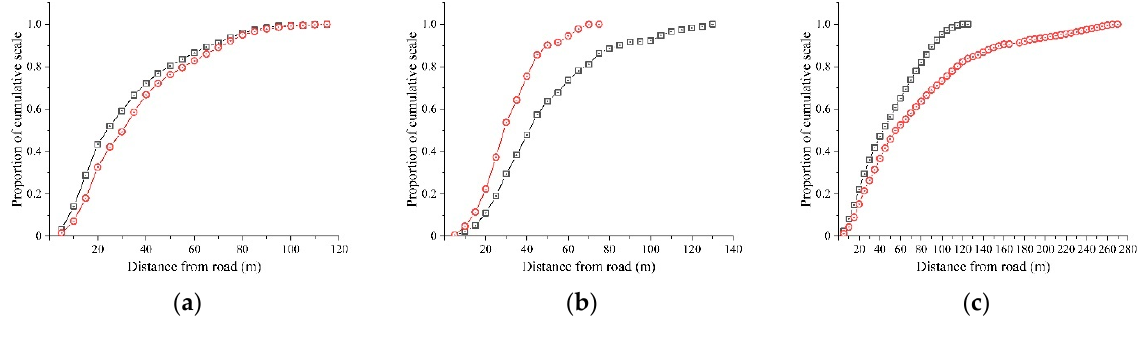
Figure 4. The scale cumulative map of rural settlement construction. ( a ) Chusong. ( b ) Dongbo. ( c ) Zhaburang.